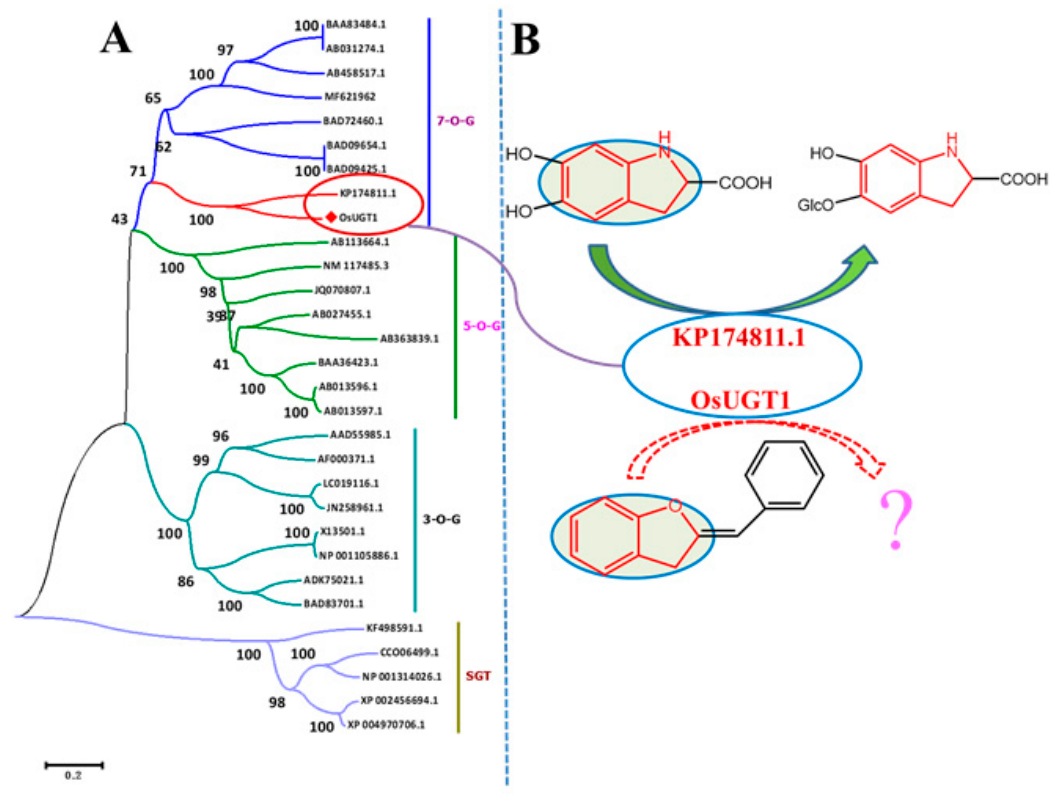
Figure 3. ( A ) Phylogenetic analysis of OsUGT1 with other GTs of known function. The deduced amino acid sequences were aligned with CLUSTAL X Version 2.0. The tree was constructed by the neighbor-joining method of MEGA 7.0. Numbers indicate the bootstrap values of 1000 replicates. The scale bar represents 0.2 amino acid substitutions per site. Different glycosyltransferases are clustered into 4 clads with varied colors based on the regioselectivity upon the substrate acceptors.